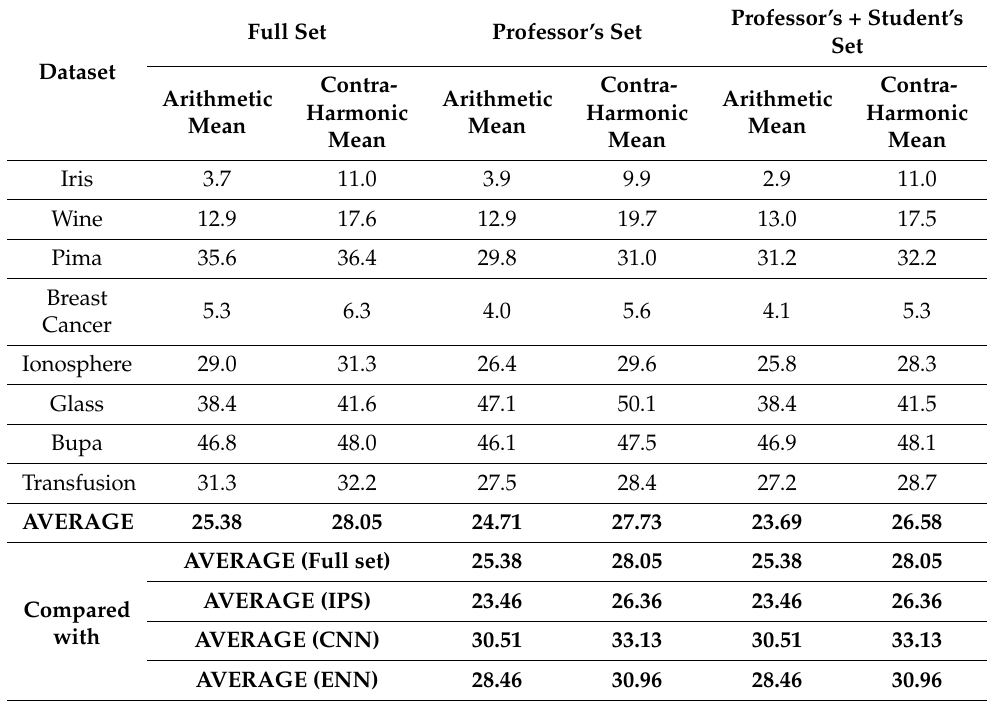
Table 4. Results of the experiments with the Adversarial Prototype Selection (Error Rate).